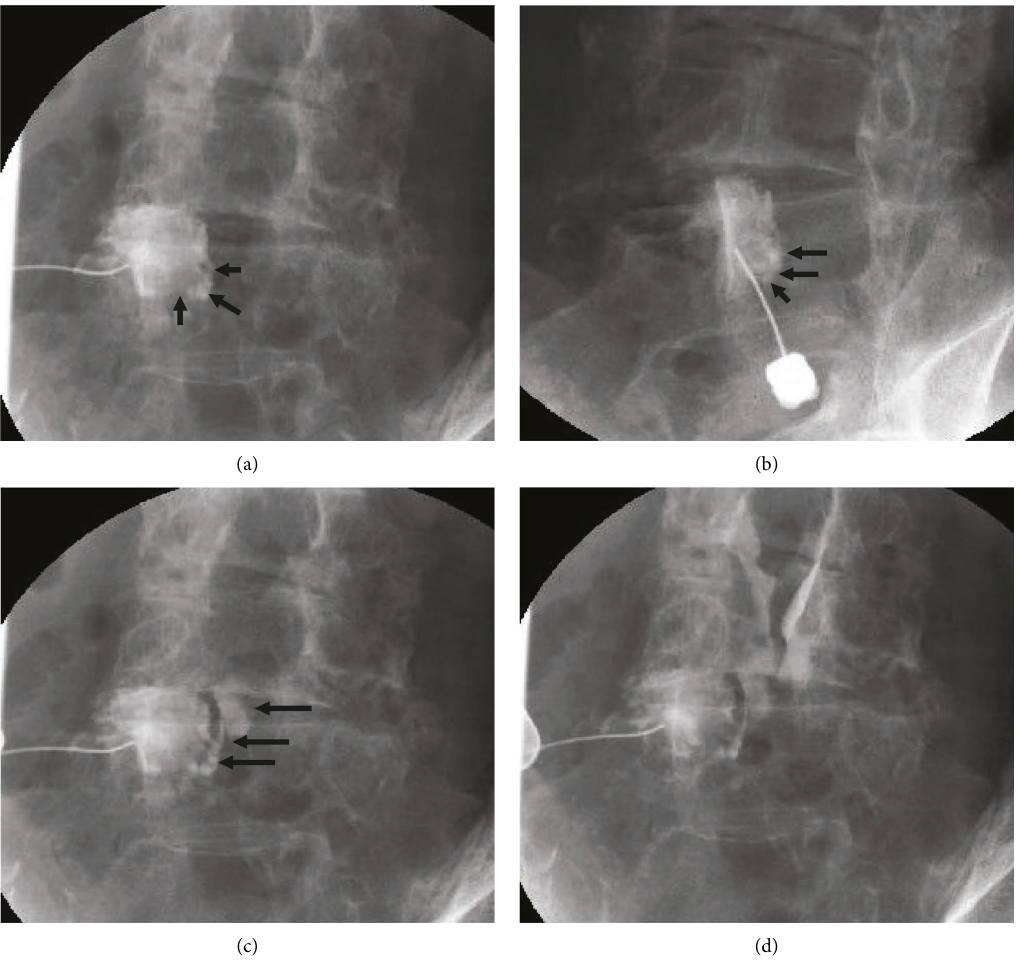
Figure 2: Fluoroscopic image of LFC rupture. (a), (b) Contrast imaging of the facet joint and cyst (arrow), (c) rupture of the cyst with leaked contrast agent (arrow), and (d) spread of contrast agent into the epidural space.